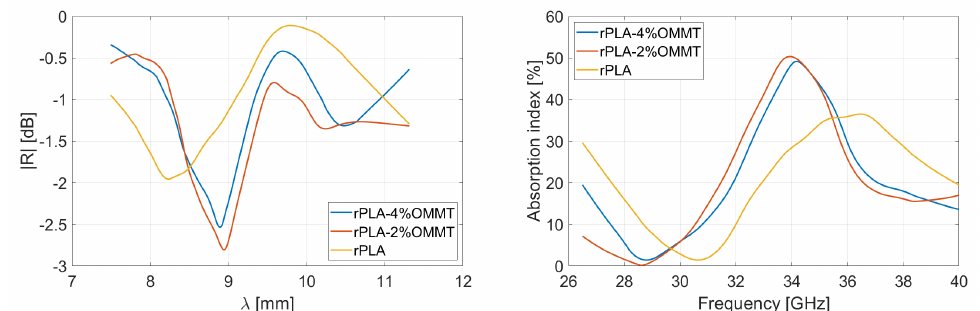
Figure 8. Measurement in Rozanov configuration of reflectivity versus wavelength and absorption versus frequency of recycled PLA films having various wt.% concentration in OMMT. Thickness of films is 400 µm.